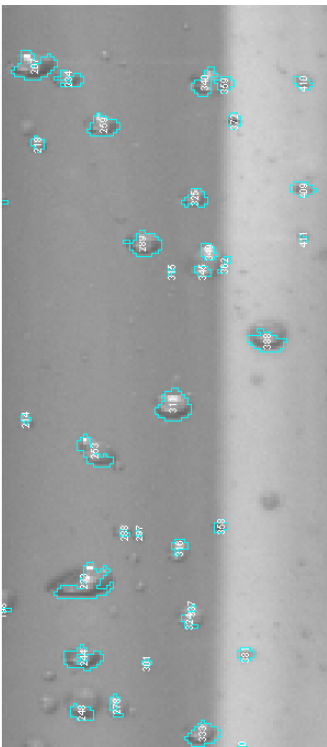
Figure 3. Example image of bubble identification (identified bubbles are outlined). Note that out-of-focus bubbles are not identified due to the blurred edges.